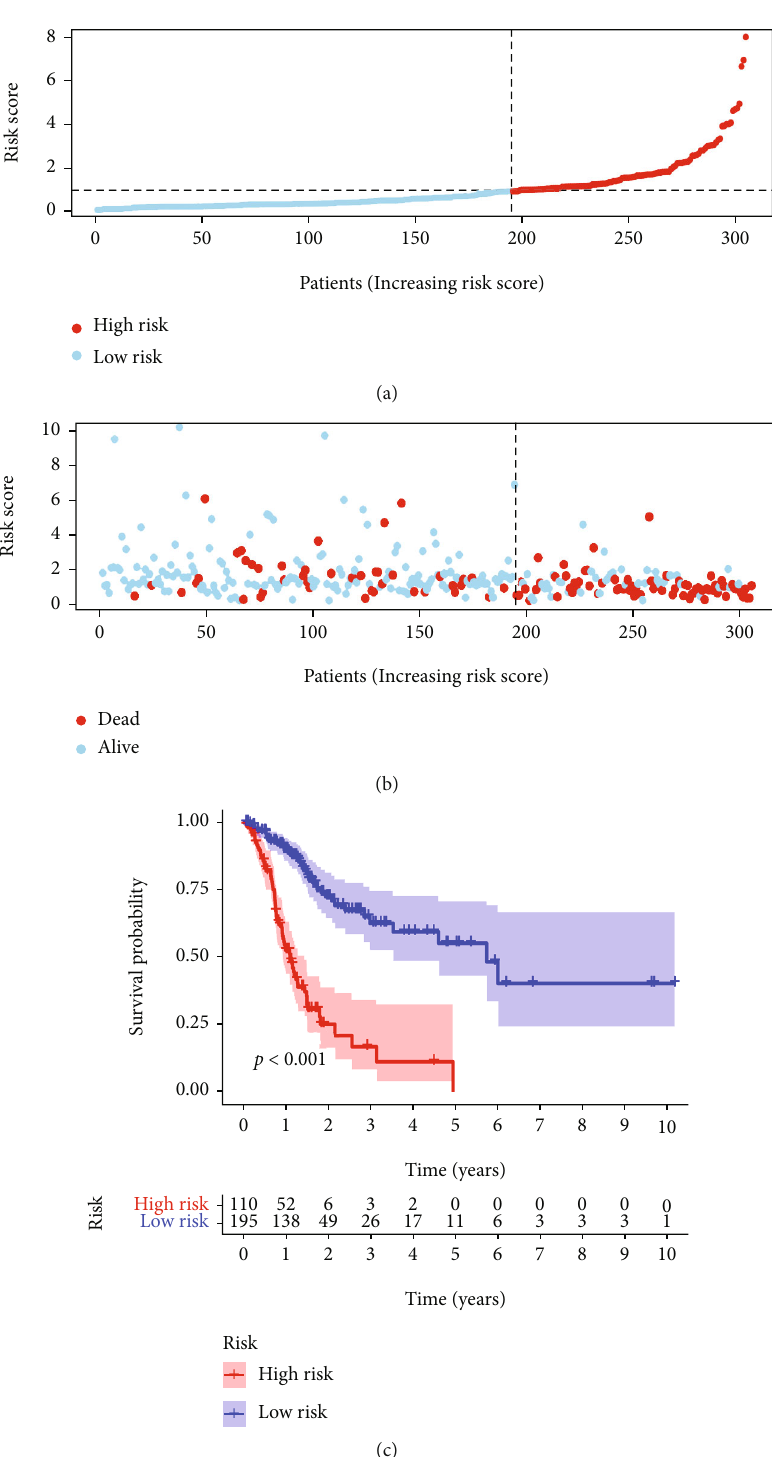
Figure 4: Prognosis of the risk model. Patients were ranked according to the risk score (a). The survival status of the patients in high-risk and low-risk group (b). Kaplan Meier was used to visualize survival probability of the patients in high-risk and low-risk group